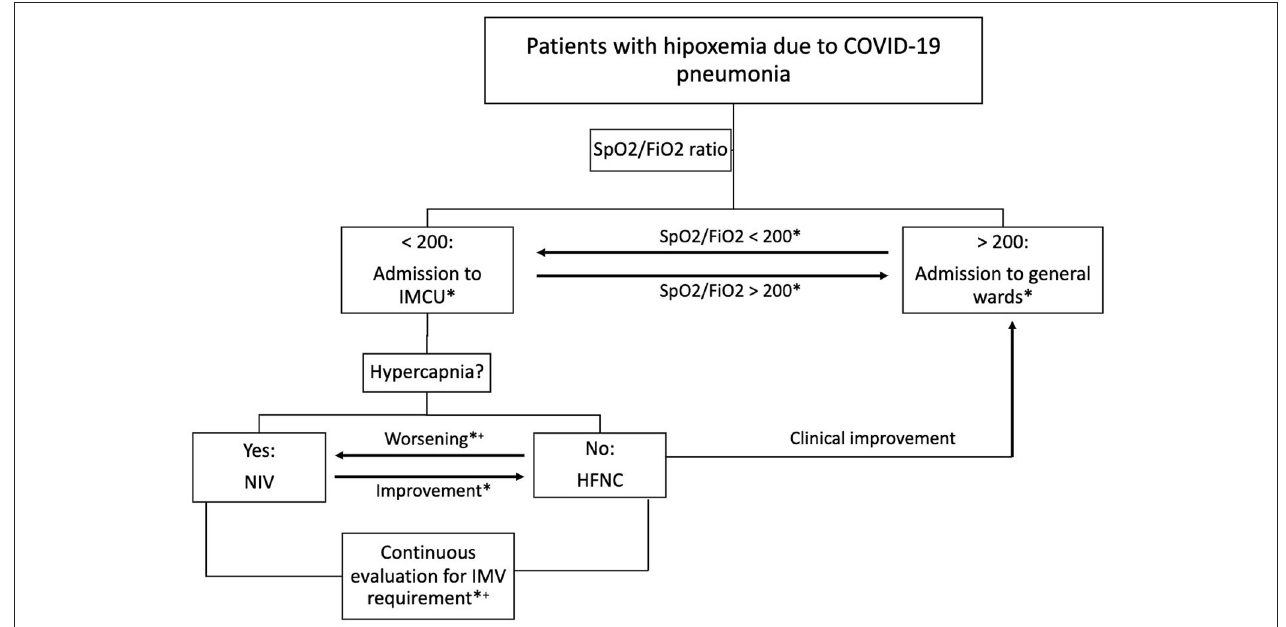
FIGURE 1 | Algorithm of multidisciplinary patient management. Clinical worsening is defined as SpO2/FiO2 < 100 and/or tachypnea > 30 breaths per minute. Clinical improvement is defined as SpO2/FiO2 > 200 and respiratory rate < 30 breaths per minute. * Daily multidisciplinary team assessment; + Transfer to ICU if IMV and/or vasoactive drugs are required. COVID-19, coronavirus disease-2019; SpO2/FiO2, oxygen saturation to fraction of inspired oxygen ratio; IMCU, intermediate respiratory care unit; ICU, intensive care unit; NIV, non-invasive ventilation; HFNC, high-flow nasal cannula; IMV, invasive mechanical